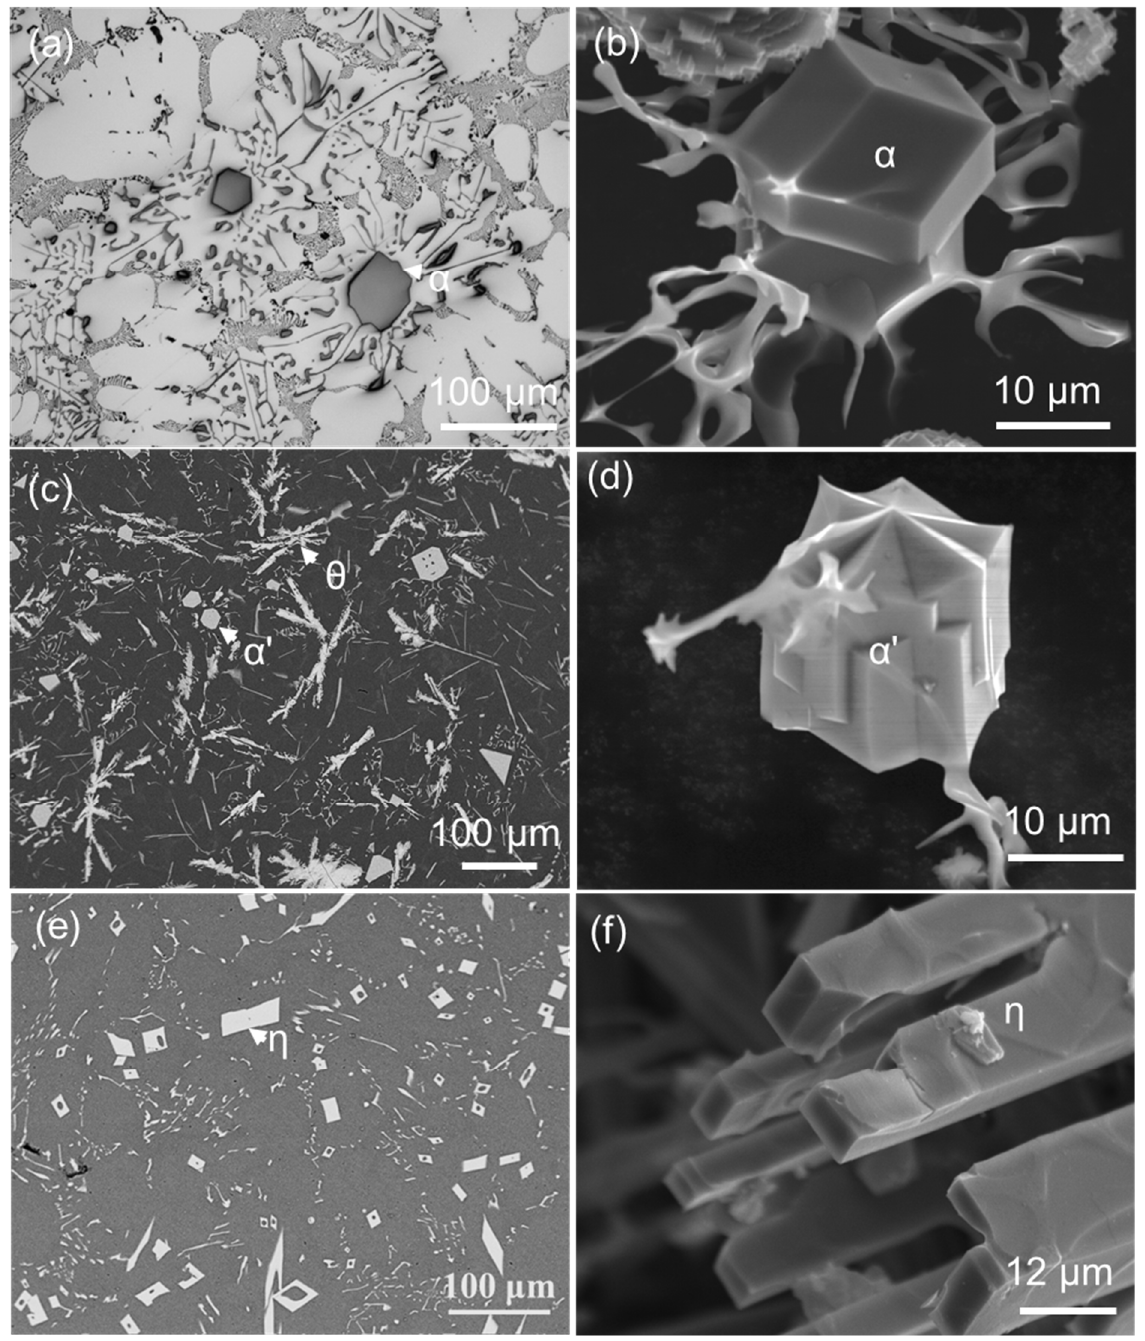
Figure 2. Same type of FIMCs have completely different morphologies when formed at different stages of solidification. ( a ) OM image, and ( b ) SEM ‐ BSD image showing that the α‐ Al 15 (Fe,Mn) 3 Si 2 has a compacted morphology as primary phase but Chinese script morphology in binary eutectic structure in Al ‐ 5Mg ‐ 2Si ‐ 0.7Mn ‐ 1.3Fe alloy [31]; ( c , d ) SEM ‐ BSD images of α ’ ‐ Al 8 Fe 2 Si showing